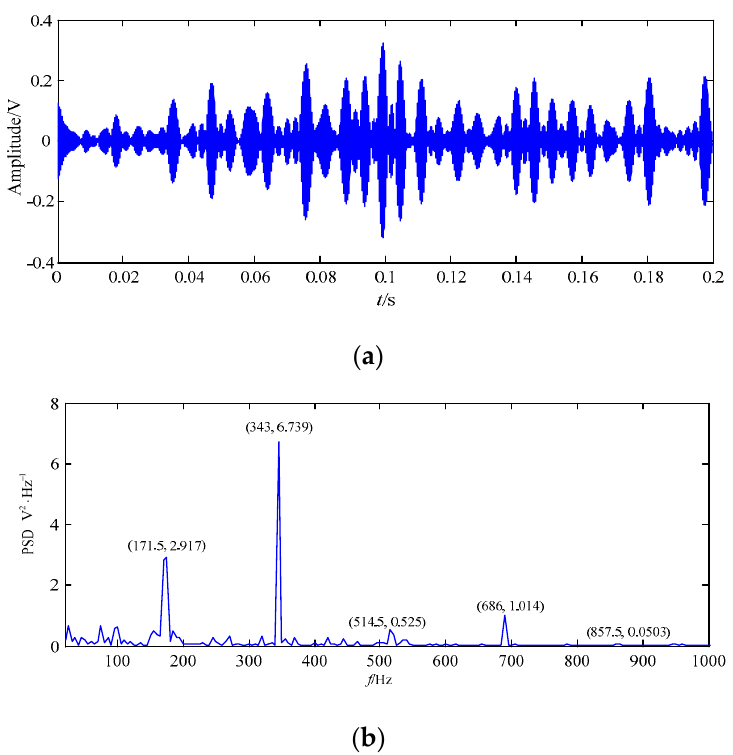
Figure 13. F 13 got based on EWT. ( a ) Time domain wave; ( b ) power spectrum density.